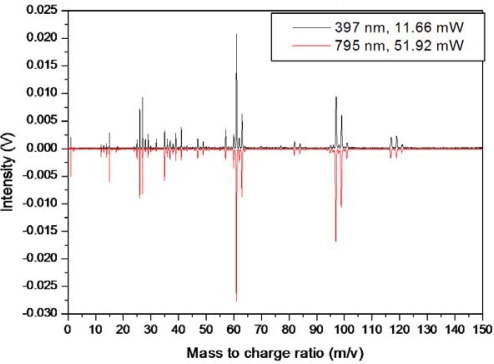
Comparison of femtosecond dissociation and ionization of trichloroethane at low intensities (1.2 × 1014 W/cm2 for 795 nm and 7.3 × 1013 W/cm2 for 397 nm). Note the 795 nm mass spectrum is plotted negatively for visual comparison.